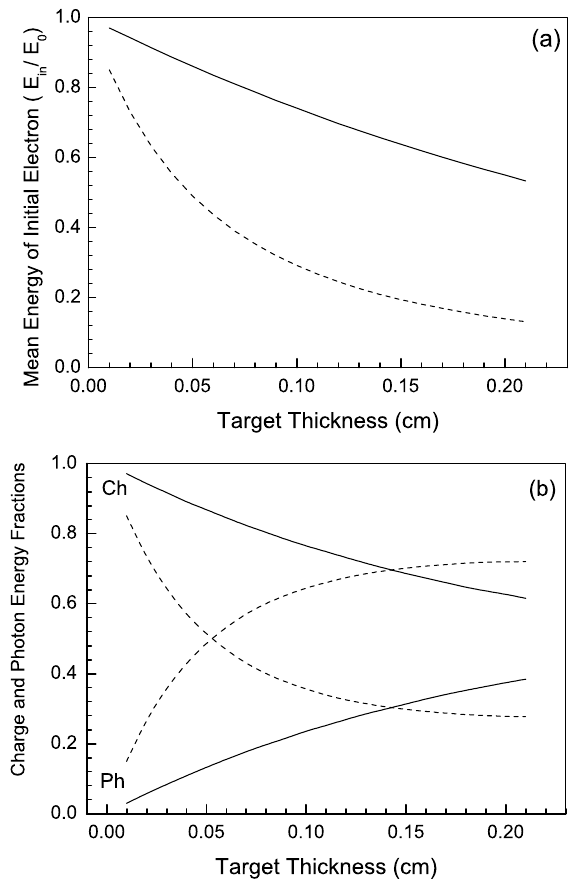
FIG. 1. Mean energy of the initial electron in units of the (cid:9) 10 GeV (a), and fractions of the incident beam energy, E 0 total energy carried correspondingly by all charged particles and photons (b). Solid lines are for amorphous and dashed lines for crystal tungsten target. The incident beam is directed along the h 111 i axis of the